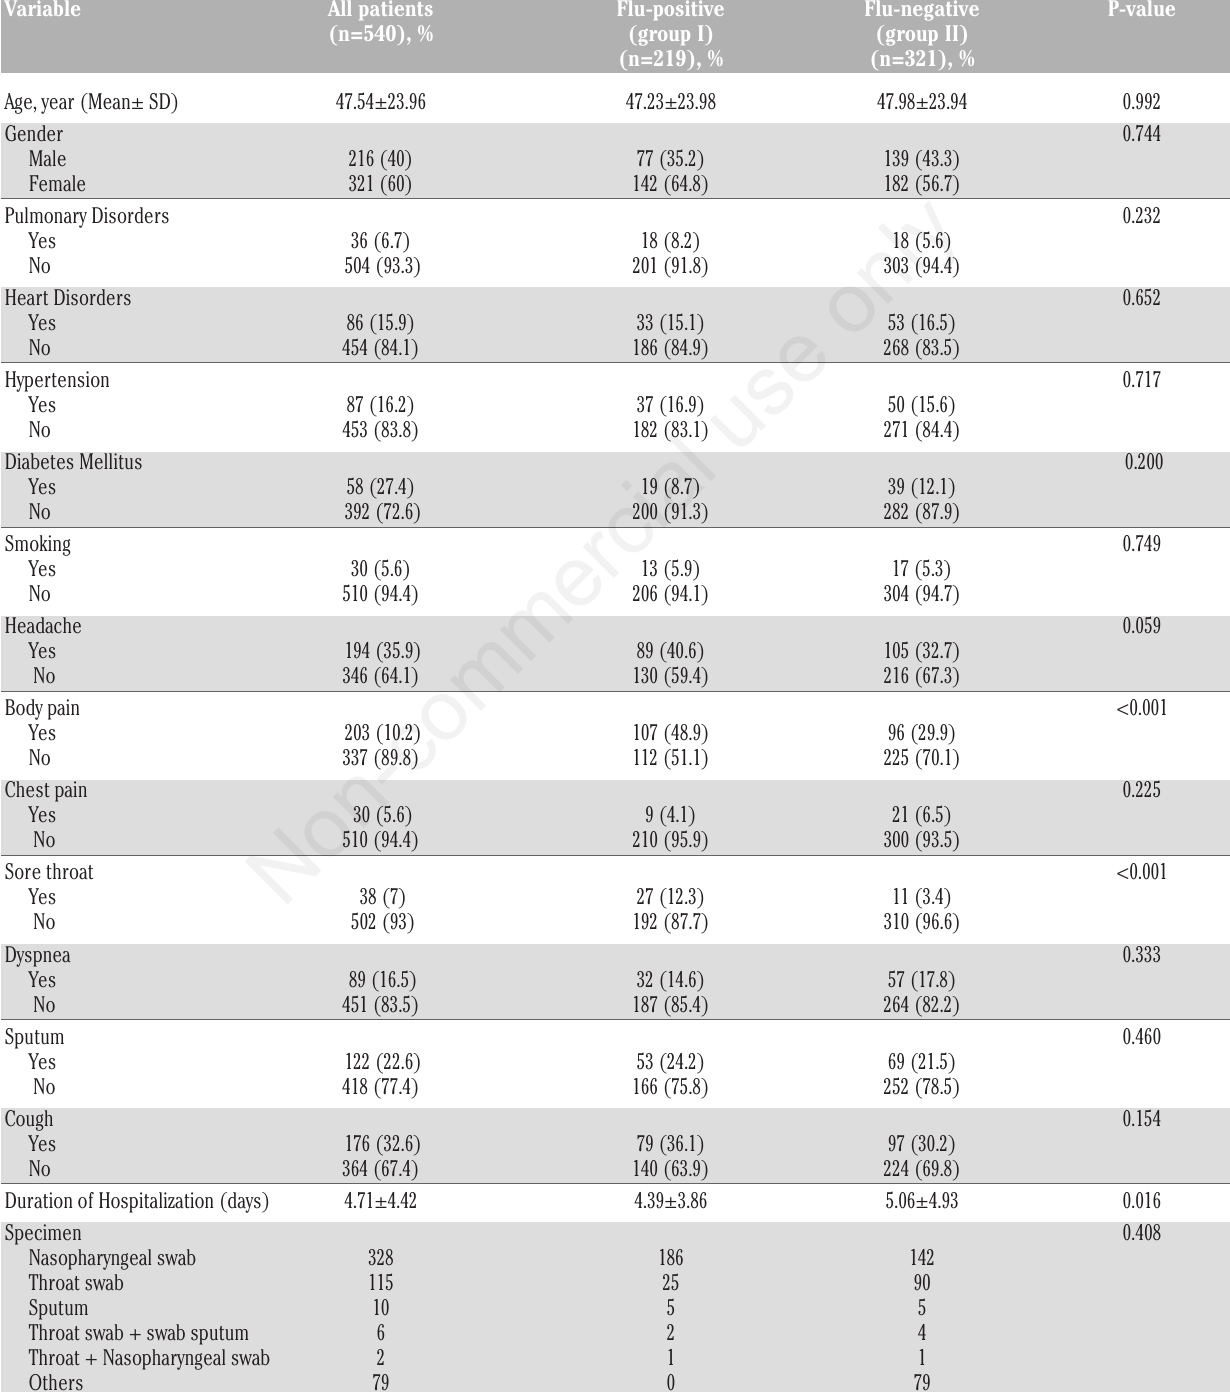
Table 1. Demographical and clinical characteristics of patients.